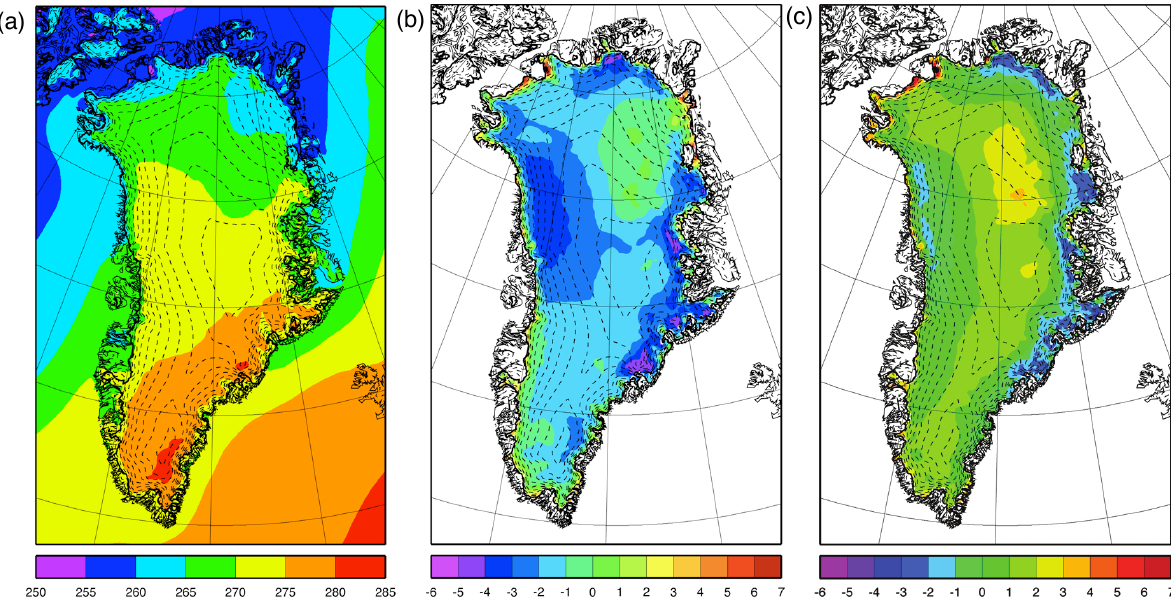
Fig. 5. (a) Annual mean 2m potential temperature [K], and (b) difference between T 2m , Reeh computed with Eq. (3) Reeh (1991) and mean annual 2m temperature of RACMO2/GR [ ◦ C], and (c) difference between T 2m computed according to (Fausto et al., 2009) and mean annual 2m temperature of RACMO2/GR [ ◦